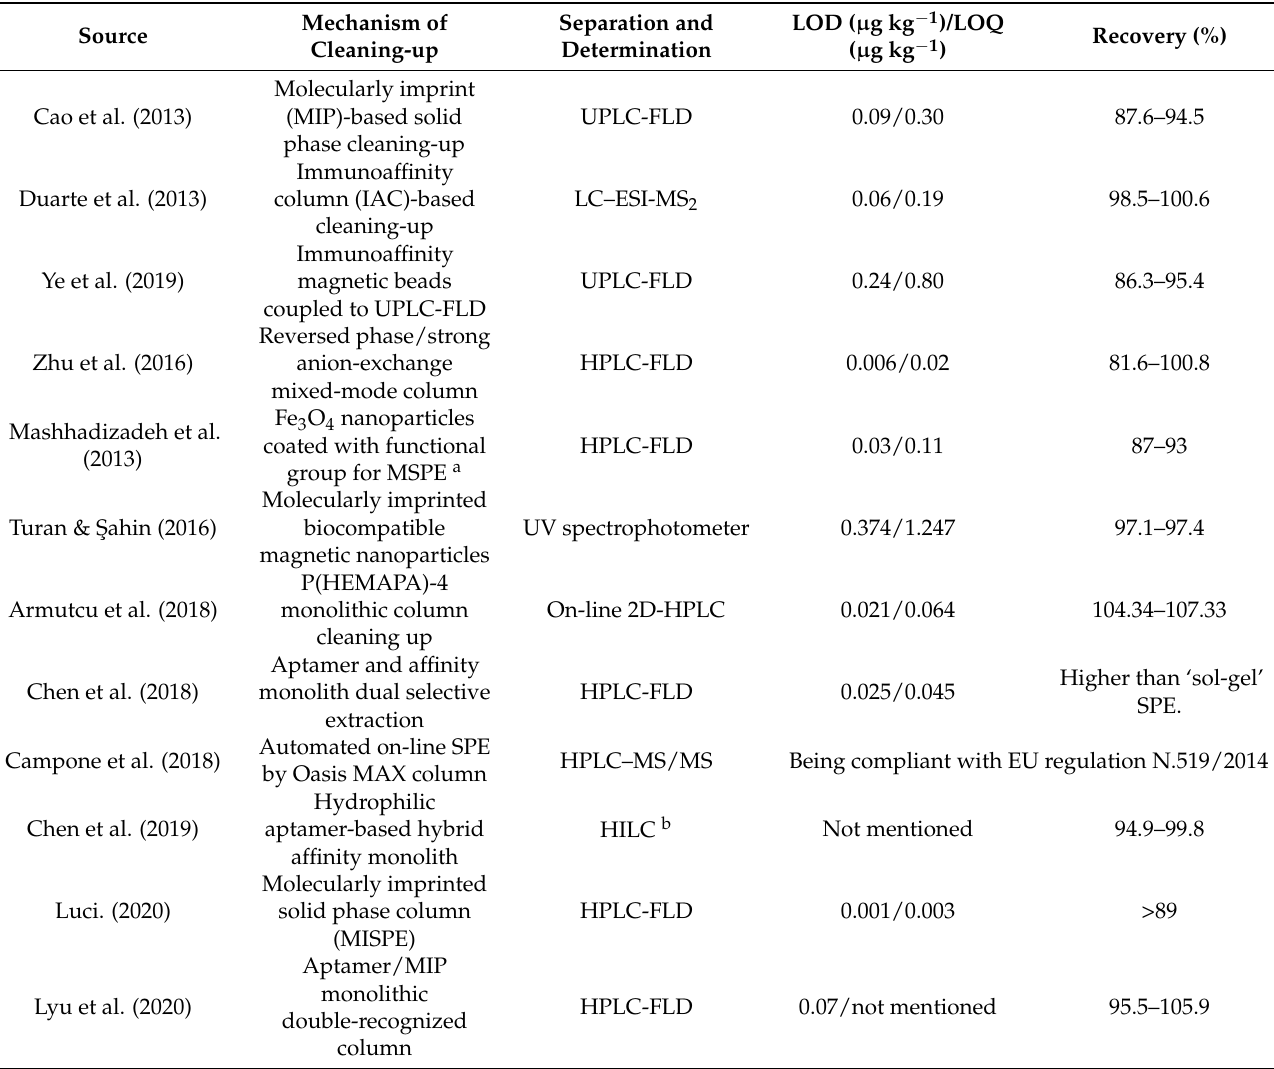
Table 4. The recent cleaning-up of Ochratoxin A for instrumental